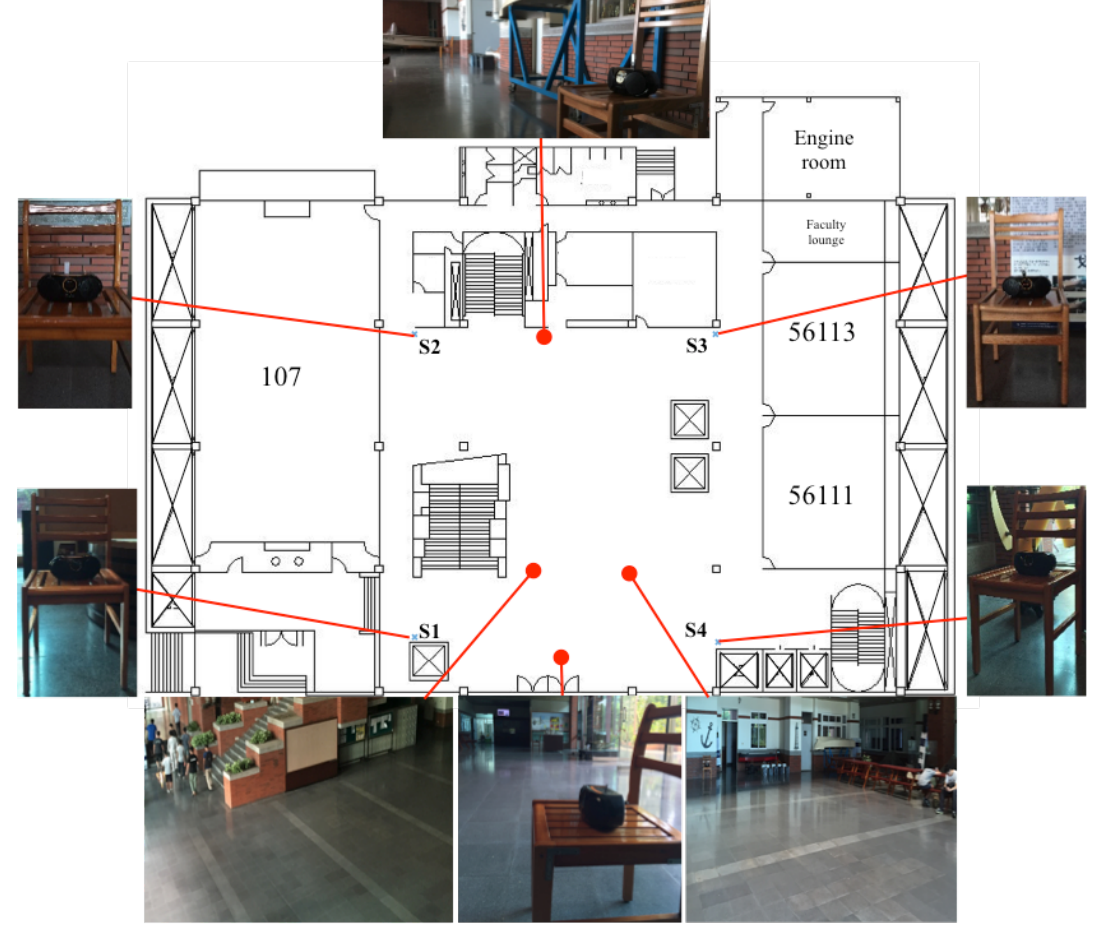
Figure 13. The test environment in the first floor of the building.